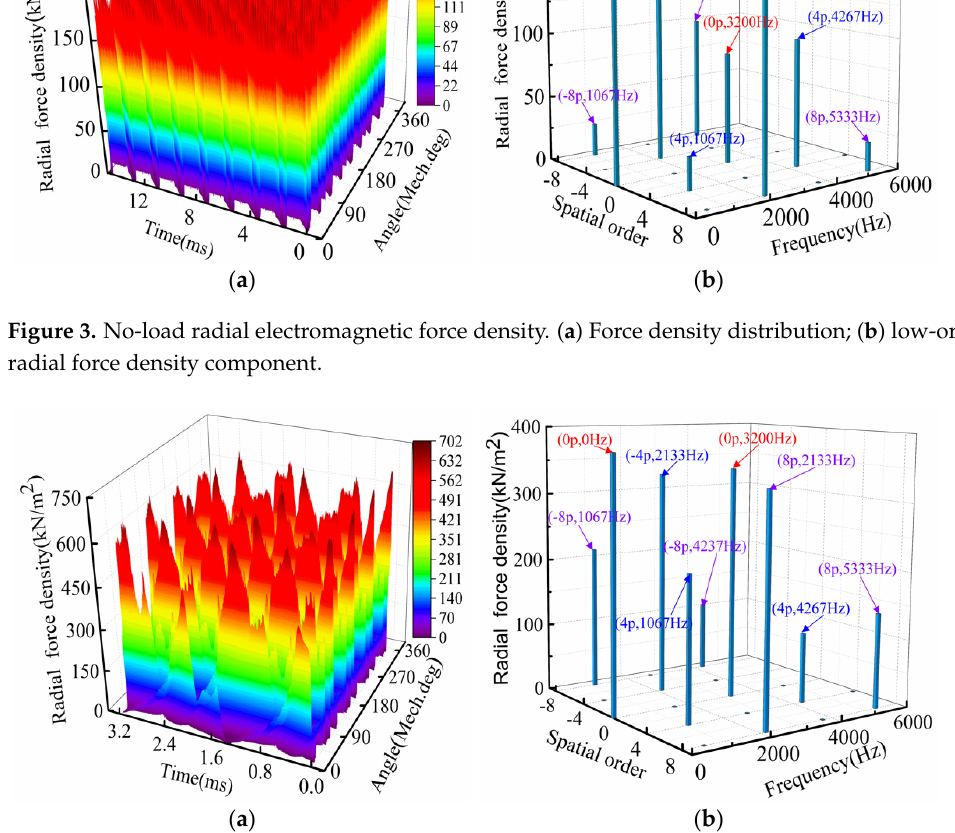
Figure 4. Load radial electromagnetic force density. ( a ) Force density distribution; ( b ) low-order radial force density component.